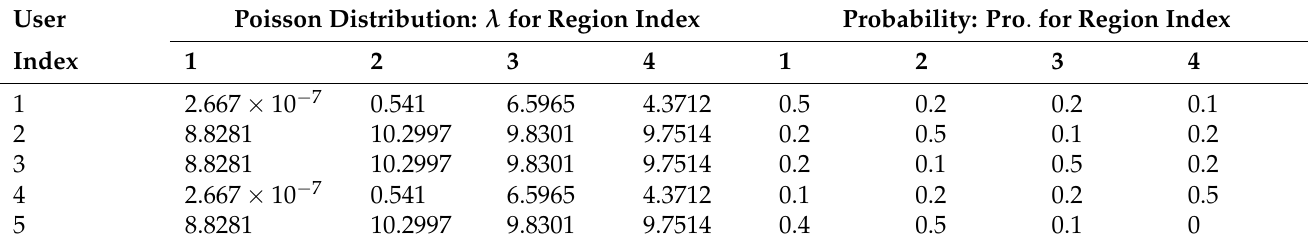
Table 4. Poisson distribution parameter and load choosing probability for different users and